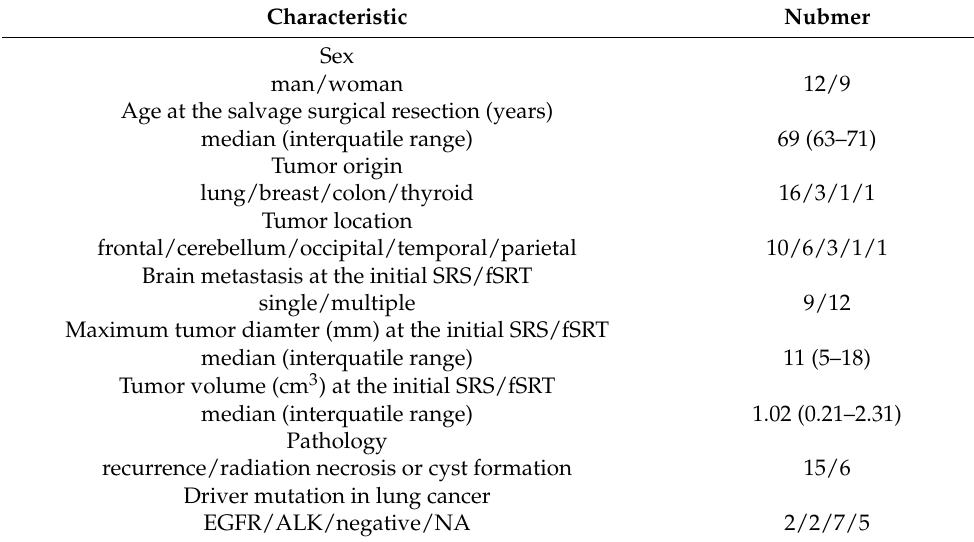
Table 1. The characteristics of all patients with SSR after